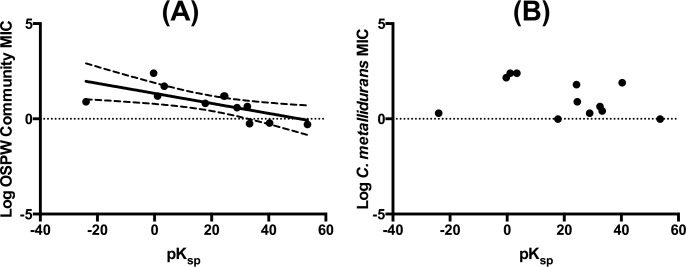
Planktonic minimal inhibitory concentrations plotted against pKsp.Significant correlation is evident with the OSPW community (A), and absent with C. metallidurans (B). Dashed lines show 95% confidence bands.